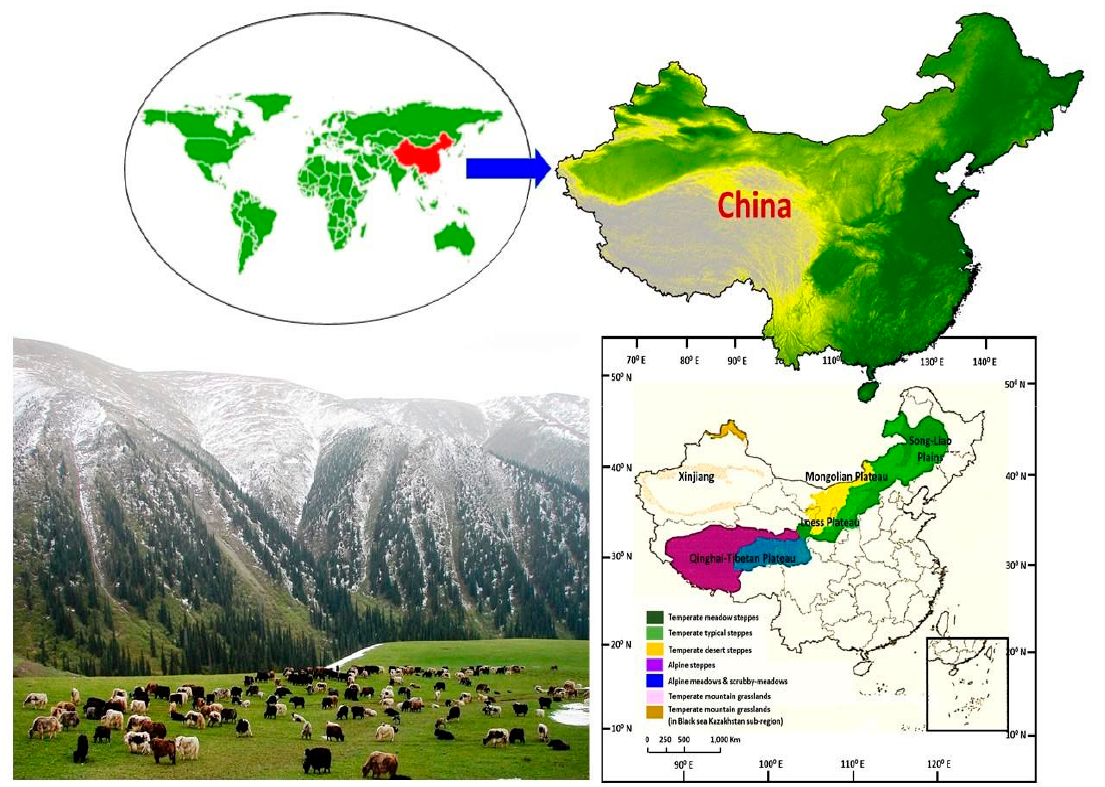
Figure 2. Maps showing right to left (clockwise) China (in red) in relation to the whole world, the location of the Qinghai–Tibet Plateau (QTP) in China (gray shaded area in SW of China) and the distribution inter alia of alpine steppes and alpine meadows on the QTP. The photo shows yaks grazing alpine grassland at an altitude of 4000 meters (photo: V.R. Squires).